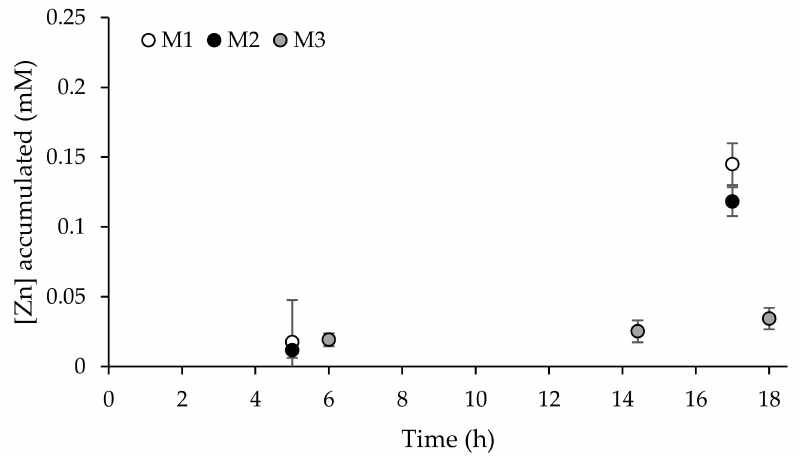
Figure 2. Effect of PIM composition on Zn accumulation at different times. Feed phase: 100 mL of a 0.03 mM Zn in 0.01 M KNO 3 , pH 6.0; PIMs: M1–M3; receiving phase: 5 mL 0.01 M HNO 3 ( n = 3).